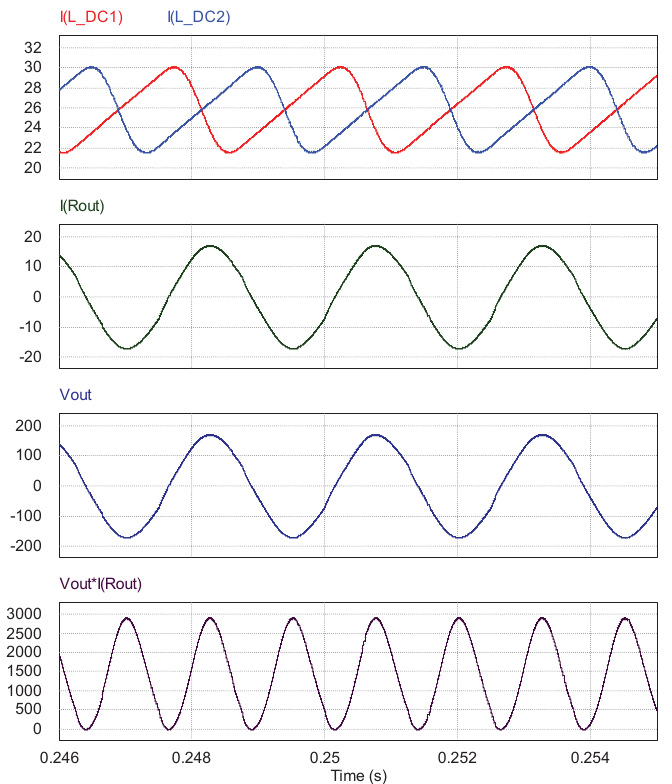
Figure 8. Simulation of the current at the DC link, output current and voltage of the inverter and inverter output power (top to bottom).